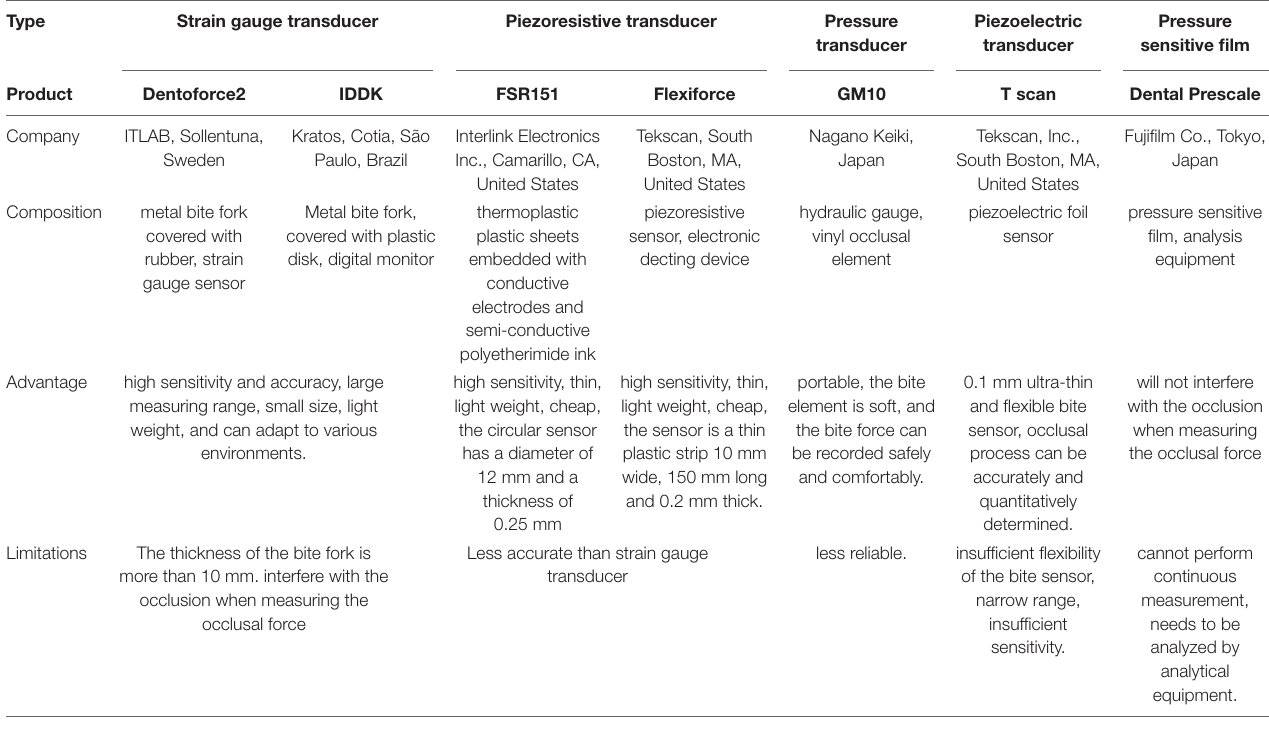
TABLE 1 | Transducers currently used for bite force